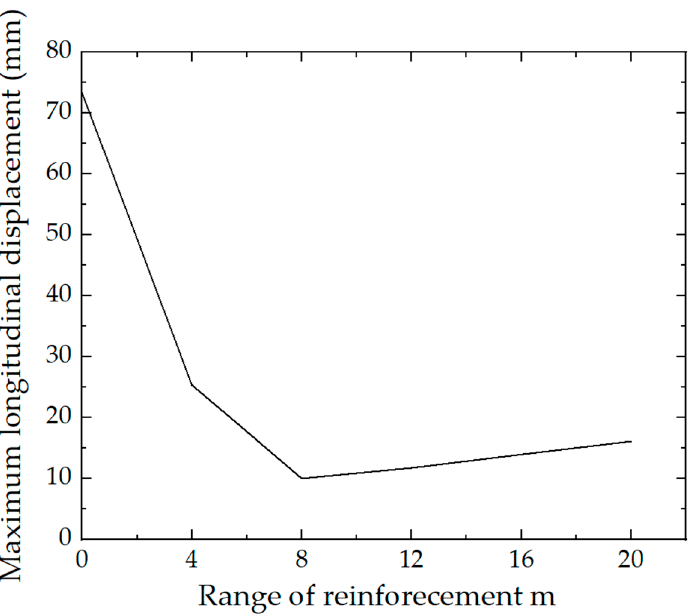
Figure 12. Maximum longitudinal displacement under different reinforcement ranges.